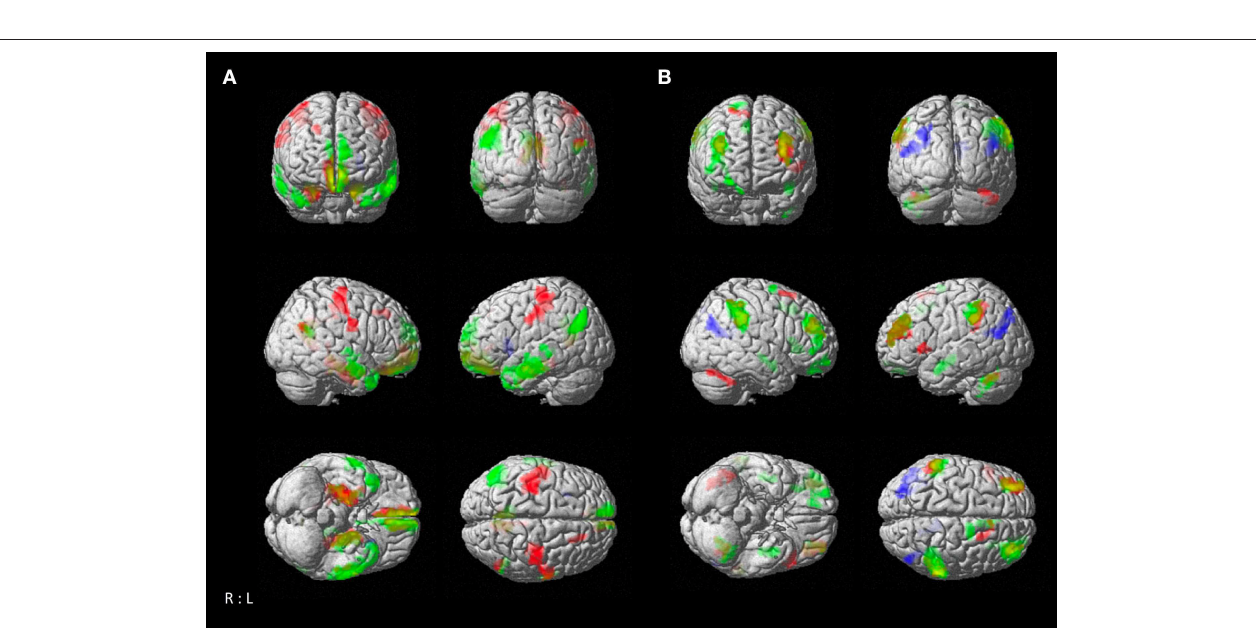
FIGURE 3 | Functional characterization of atrophy seeds by behavioral domains and paradigm classes. (A) Functional characterization by behavioral domains and paradigm classes of left temporal seed ( green ) in contrast to right temporal seed ( red ). (B) Functional characterization by behavioral domains and paradigm classes of parietal seed ( blue ) in contrast to the conjunction of left and right temporal seeds ( red ). Bar plots show significant associations (at p < 0.05, FDR corrected) of behavioral domains and paradigm classes from the BrainMap meta-data given observed brain activity (and vice versa); the x-axis indicates relative probability values.